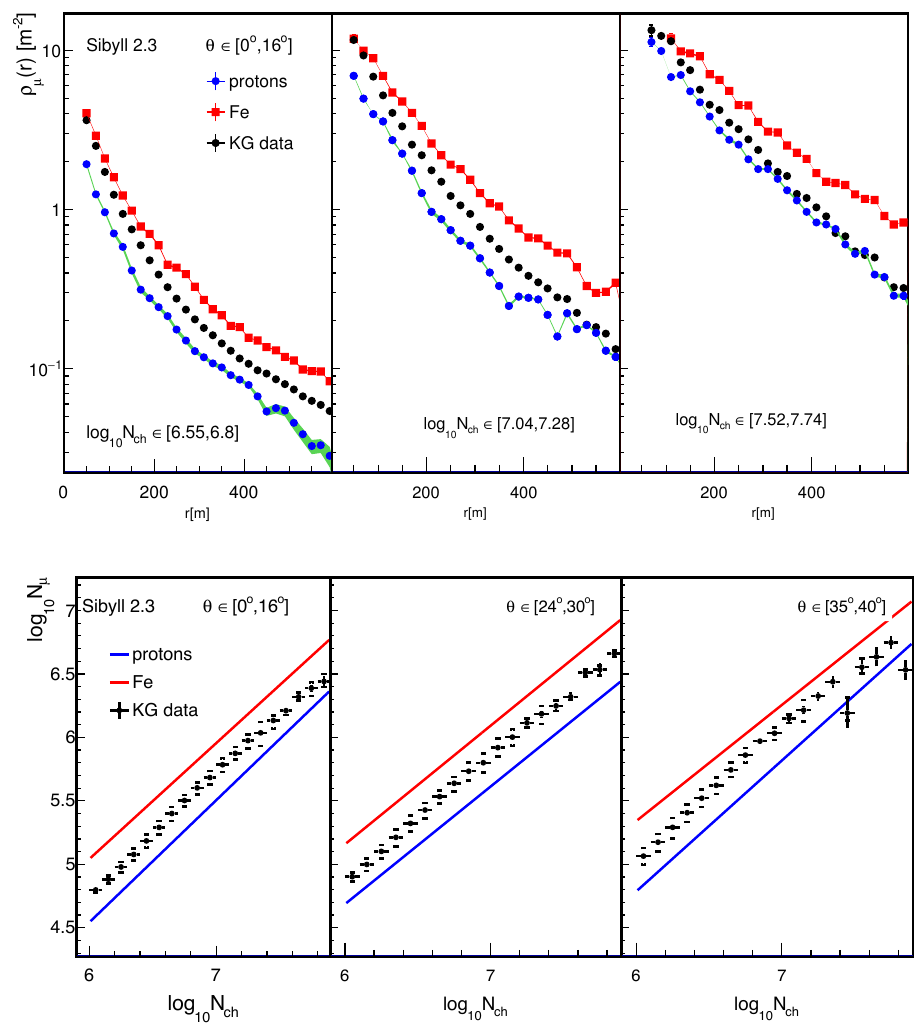
Figure 1. Upper panel : Mean muon lateral density distributions of EAS measured with KASCADE-Grande (points) compared with the predictions of SIBYLL 2.3 for iron (red upper lines) and proton (lower blue lines) primaries. Statistical error bars in measured data are smaller than the size of the markers. From MC simulations the energy scale of the above data spans the interval E [10 7 . 2 , 10 8 . 5 ]GeV. ∼ Lower panel : Logarithm of the corrected muon size versus the logarithm of the total number of charged particles in air showers as measured with the KASCADE-Grande detector (black points). Measurements are confronted with predictions of SIBYLL 2.3 for iron nuclei (upper red lines) and protons (lower blue lines). Vertical error bars represent the systematic errors (corrected N µ bias from reconstruction added in quadrature with an experimental bias that depends on the core position). Data is shown for the interval N ch = 10 6 10 7 . 9 , which roughly corresponds to mean primary energies in the range E [10 6 . 8 , 10 9 . 1 ]GeV for the measured data. − ∼ The primary energy for both panels was estimated event-by-event from both N ch and the corrected N µ using a formula calibrated with SIBYLL 2.3 simulations (following the procedure of